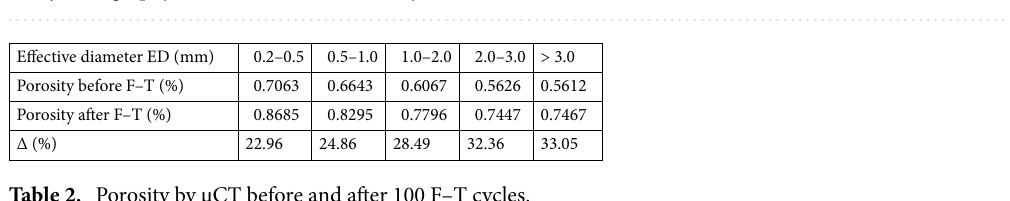
Figure 7. Histogram showing pore size distribution of macropores (due to the used voxel size of 34 µm/voxel, we were able to scan only pores with an effective diameter larger than 136 µm) in andesite determined by Micro X-ray tomography before and after 100 F–T cycles.